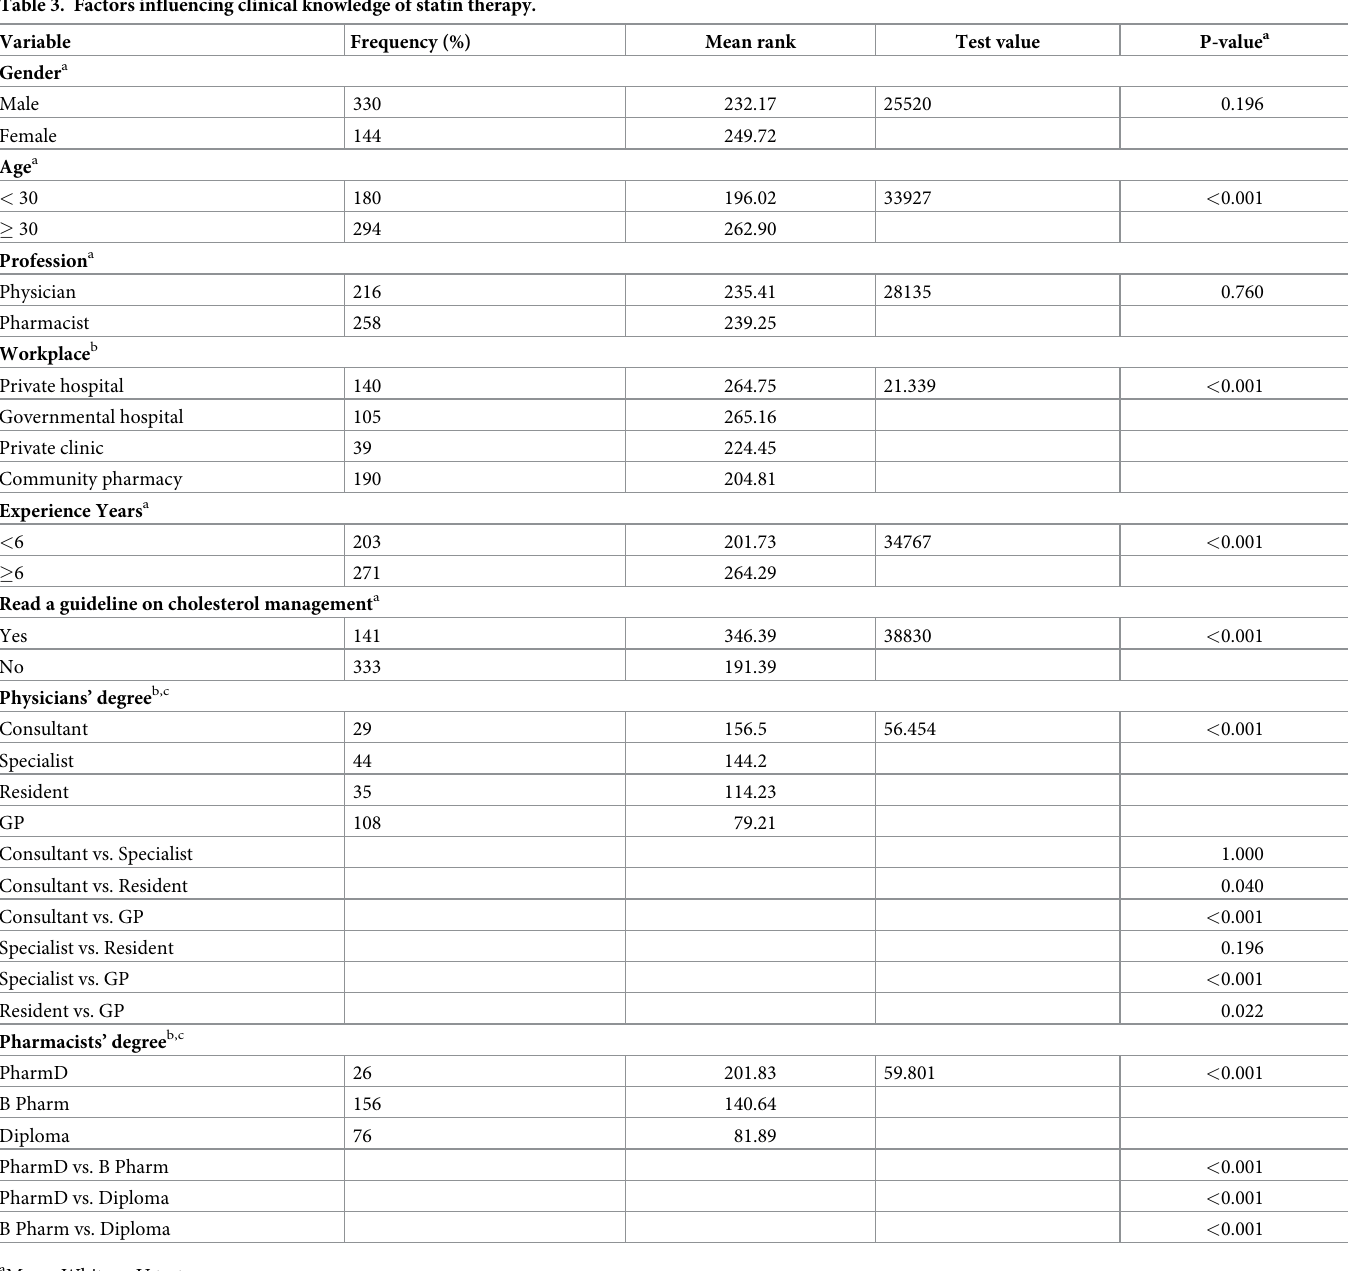
Table 3. Factors influencing clinical knowledge of statin